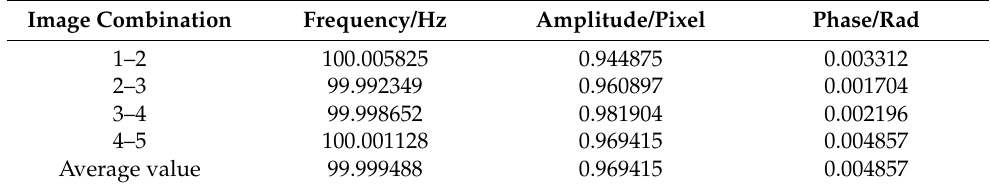
Table 4. The 100-Hz jitter modeling results by single disparity map.